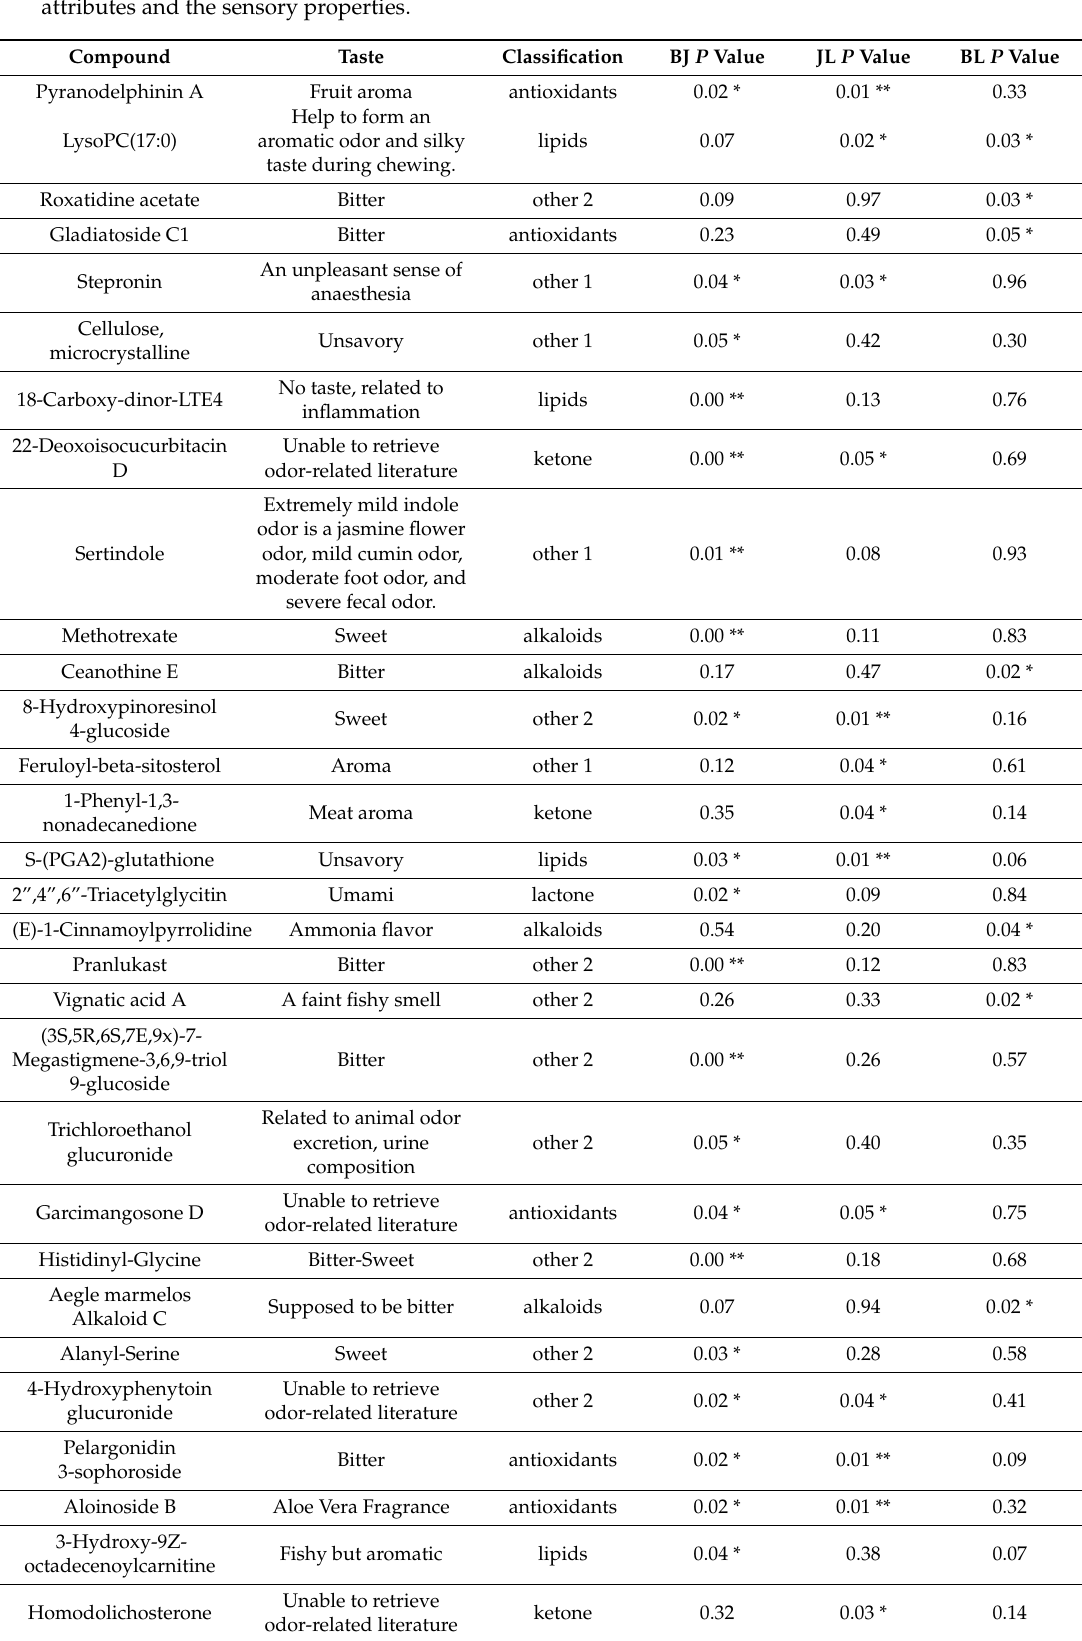
Table 3. 30 di ff erential metabolites in the three types of goat meat with a correlation between the taste attributes and the sensory